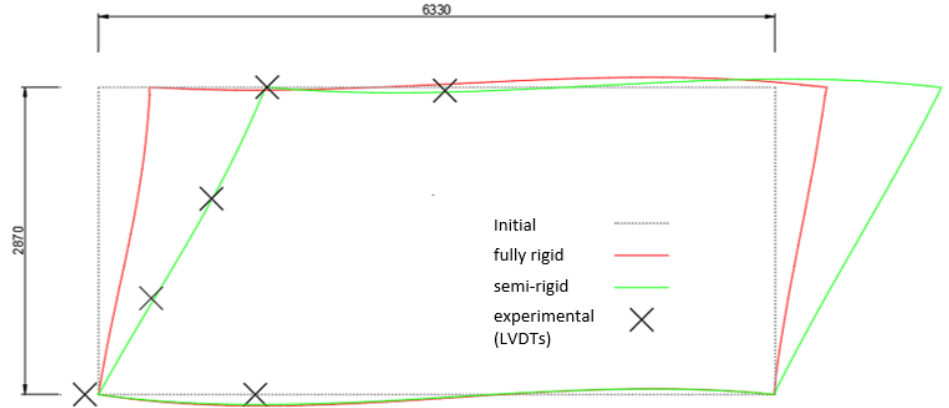
Figure 17. Deformed shape of the GFRP frame corresponding to a lateral load of 45 kN: experimental displacement values, numerical displacement distributions with fully rigid and semi-rigid behaviours (measures in mm).